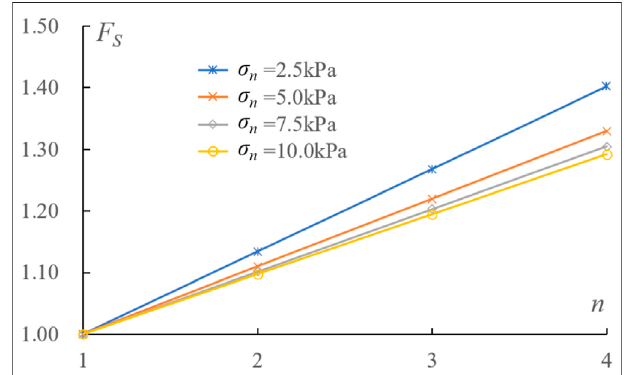
FIGURE 11 | Variation curves of scale